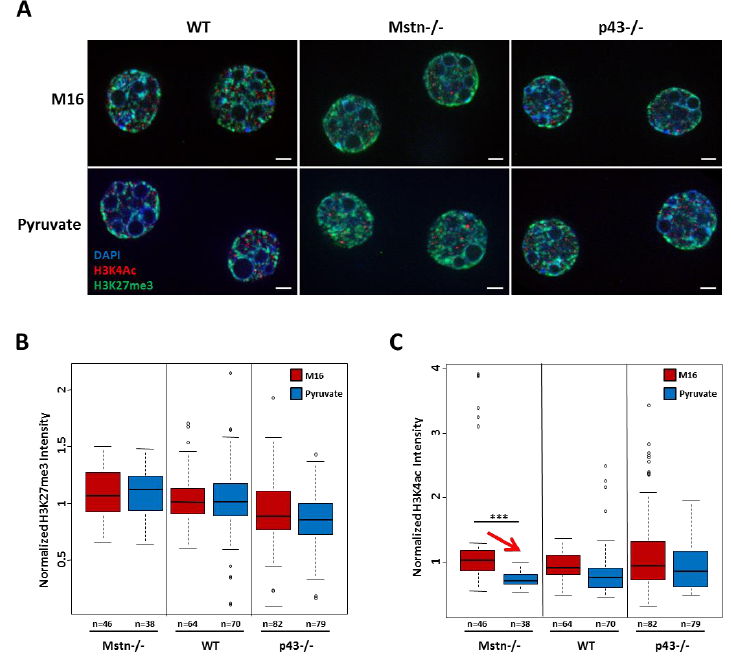
Figure 7. Culture medium containing pyruvate alone decreased H3K4 acetylation in Mstn−/− 2-cell embryo. ( A ) Representative staining of 2-cell embryos labelled with DAPI (4′,6-diamidino-2- phénylindole) and antibodies raised against H3K4Ac or H3K27me3. Scale bar: 5 µm. ( B ) Quantification of H3K27me3 fluorescent intensity normalized by DAPI fluorescent intensity. ( C ) Quantification of H3K4Ac fluorescent intensity normalized by DAPI fluorescent intensity. Red arrow indicates a significant decrease. For C57Bl6/6 nuclei, n = 64 in M16 medium and 70 in M16/pyruvate medium. For Mstn−/− nuclei, n = 46 in M16 medium and 48 in M16/pyruvate medium. For p43−/− nuclei, n = 82 in M16 medium and 79 in M16/pyruvate medium. Statistical Significance: *** p < 0.001, with non-parametric test using R project (Kruskal–Wallis). Results are expressed as ± sem. 3. Discussion Early mammalian embryos utilize pyruvate, lactate, and/or amino acids as the major source of energy rather than glucose before the morula stage [36,37]. In this study, we investigated the influence on the adulthood phenotype of a transient change in the metabolism of 1 cell embryos. To this end, we compared a medium which contains pyruvate, lactate, and glucose as a carbohydrate energy source and a medium containing pyruvate as the only source of carbohydrate. Pyruvate goes into the embryo both passively and by means of a facilitated carrier [38]. Pyruvate alone in the medium is known to induce a transient NAD(P)H oxidation and stimulate mitochondrial activity [12]. Indeed, in Banrezes et al. (2011), the authors cultivated PN stage embryos in a medium with variation in carbohydrate contents (only lactate or only pyruvate or none of them). They used FADH2/FAD2+ ratio to measure mitochondrial activity and showed that, with pyruvate as the only source of carbohydrate, the FADH2/FAD2+ ratio is maintained, and the mitochondrial NAD(P)+ is increased [31]. These results are consistent with previous studies on mouse oocytes and embryos that demonstrated that pyruvate induces an increase of NAD(P)H oxidation and therefore stimulates mitochondrial activity [12,31]. In this work, more than 200 male and female mice were monitored and